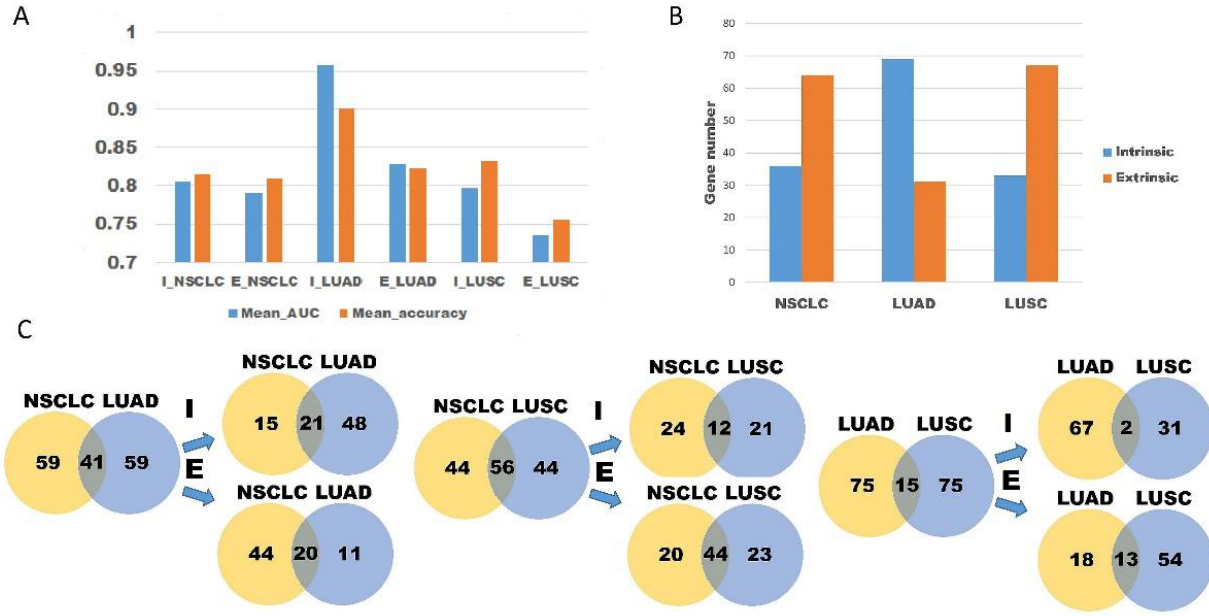
Figure 5. Differences in transcriptional patterns among NSCLC, LUAD, and LUSC. ( A ) The mean AUC and accuracy of six machine learning models according to the cellular subtype and intrinsic or extrinsic pathway. ( B ) Differences in the proportion of intrinsic and extrinsic genes among NSCLC, LUAD, and LUSC. ( C ) Overlapping patterns of intrinsic and extrinsic genes in NSCLC, LUAD, and LUSC. AUC, area under the ROC curve; E, extrinsic; I, intrinsic; LUAD, lung adenocarcinoma; LUSC, lung squamous cell carcinoma; NSCLC, non-small cell lung cancer.